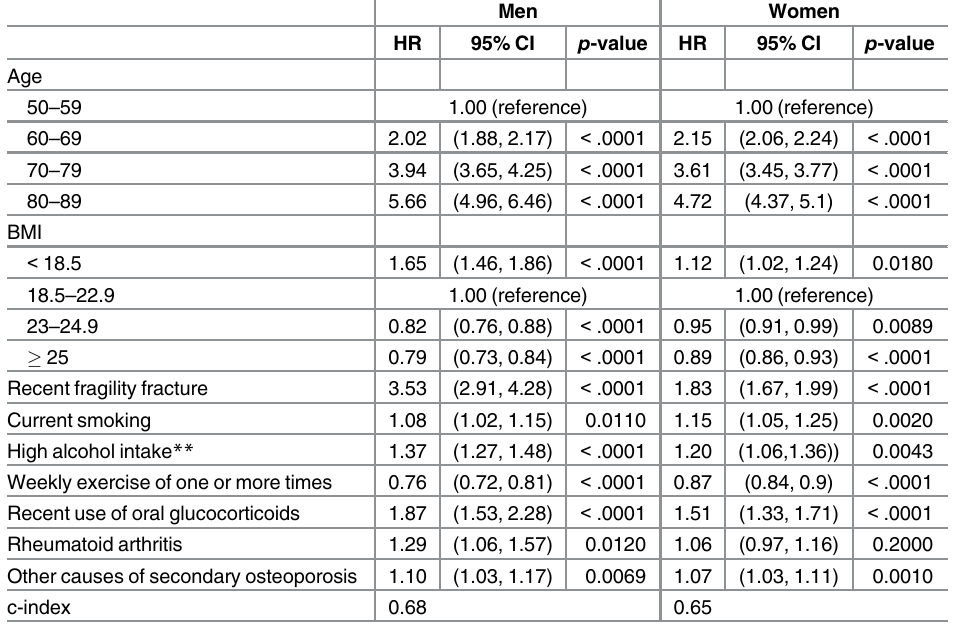
Table 3. Hazard ratios (HR) for fracture * risk factors in men and women in the modeling